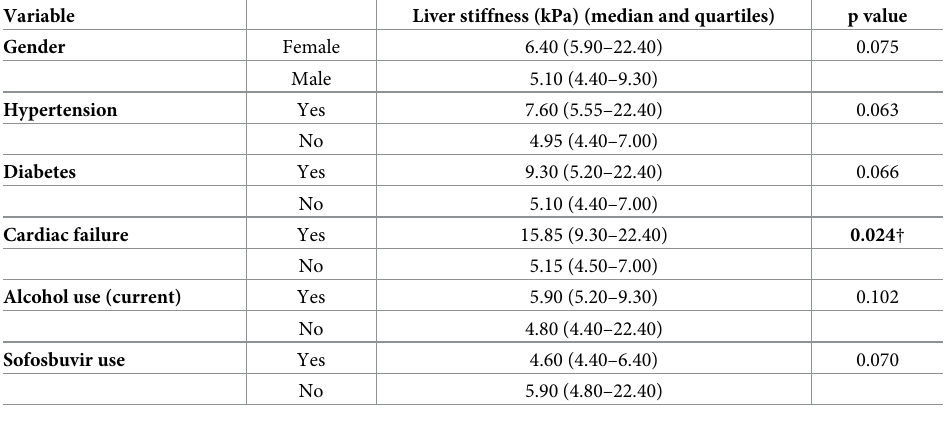
Table 2. Differences in fibrosis estimations of 18 patients who had severe yellow fever 6 months after onset of symptoms according to clinical and demographic characteristics, Brazil, 2018.